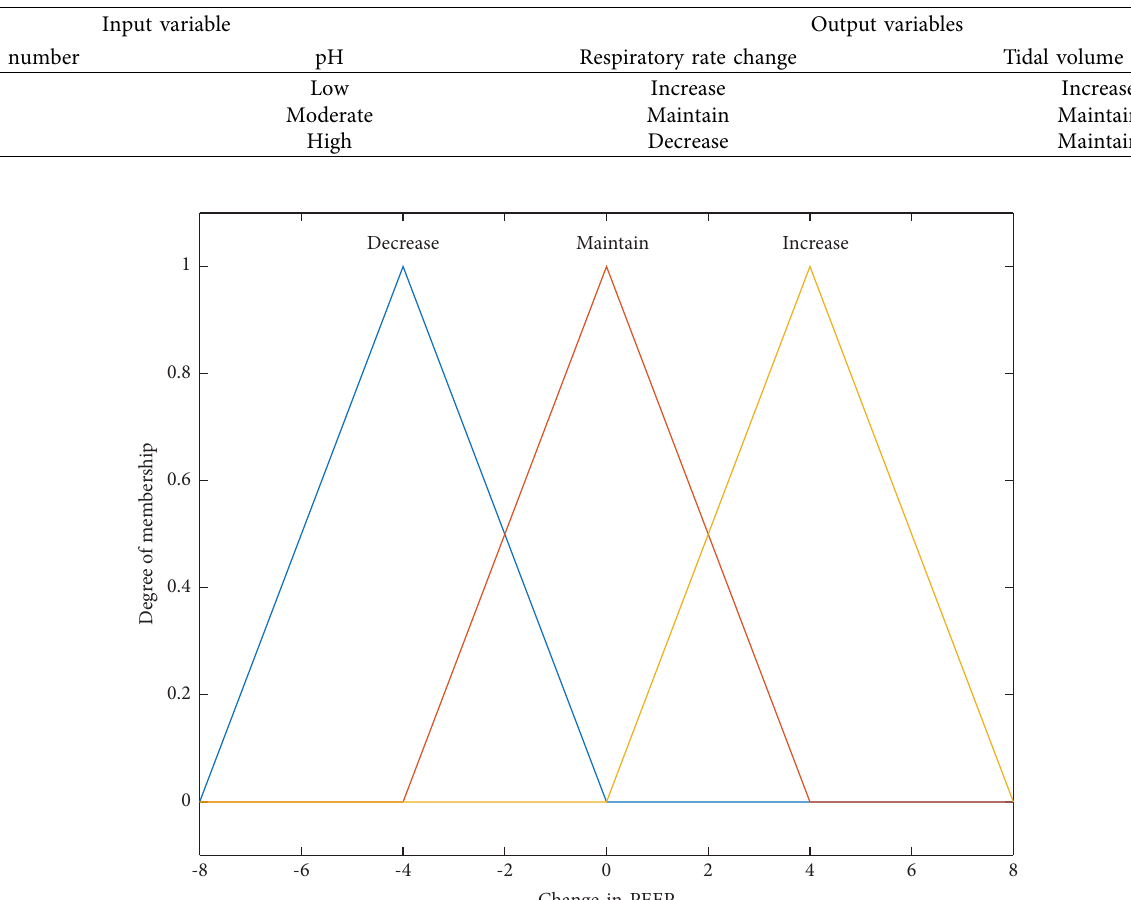
Figure 5: FiO 2 and PEEP input system. Table 8: pH, respiratory rate, and tidal volume fuzzy set rules.